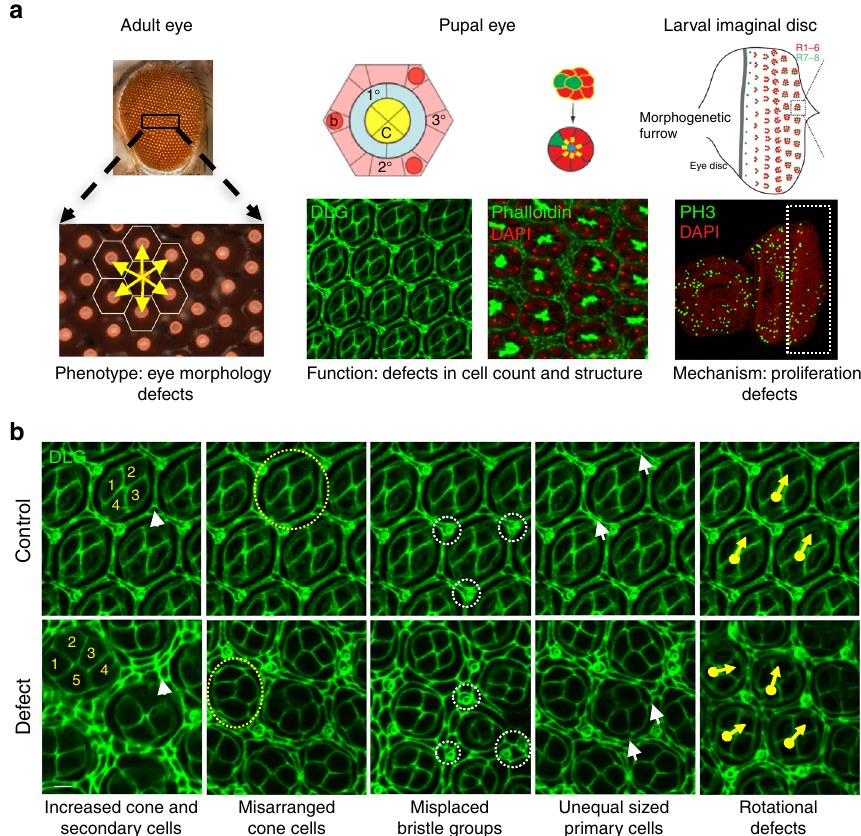
Fig. 4 Screening strategy for neurodevelopmental defects in the developing fl y eye. a Schematics and images of the wild-type adult, pupal, and larval eye show the cell organization and structure of the fl y eye during development. The wild-type adult eye displays a symmetrical organization of ommatidia, and Flynotyper software detects the center of each ommatidium (orange circle) and calculates a phenotypic score based on the length and angle between the ommatidial centers. Illustrations of the wild-type pupal eye show the arrangement of cone cells (C), primary pigment cells (1°), and secondary pigment cells (2°) along the faces of the hexagon, and bristle cells (b) and tertiary pigment cells (3°) at alternating vertices, as well as the eight photoreceptor cells within an ommatidium. The larval imaginal disc schematic shows proliferating cells posterior to the morphogenetic furrow. Pupal eyes were stained with anti-Dlg and phalloidin to visualize ommatidial cells and photoreceptor cells, respectively, while the larval eye was stained with anti-pH3 to visualize proliferating cells. Diagrams of the pupal and larval eye were generated by Frank Pichaud 69 and Joan E. Hooper 70 and are reprinted with permission from the publishers. b Example images of pupal eyes stained with anti-Dlg illustrate the structure and organization in control and knockdown fl ies. Circles and arrows indicate differences in cell organization between control and knockdown pupal eyes (yellow circles: cone cell number and organization, white circles: bristle groups, white arrowheads: secondary cells, white arrows: primary cells, yellow arrows: rotation of